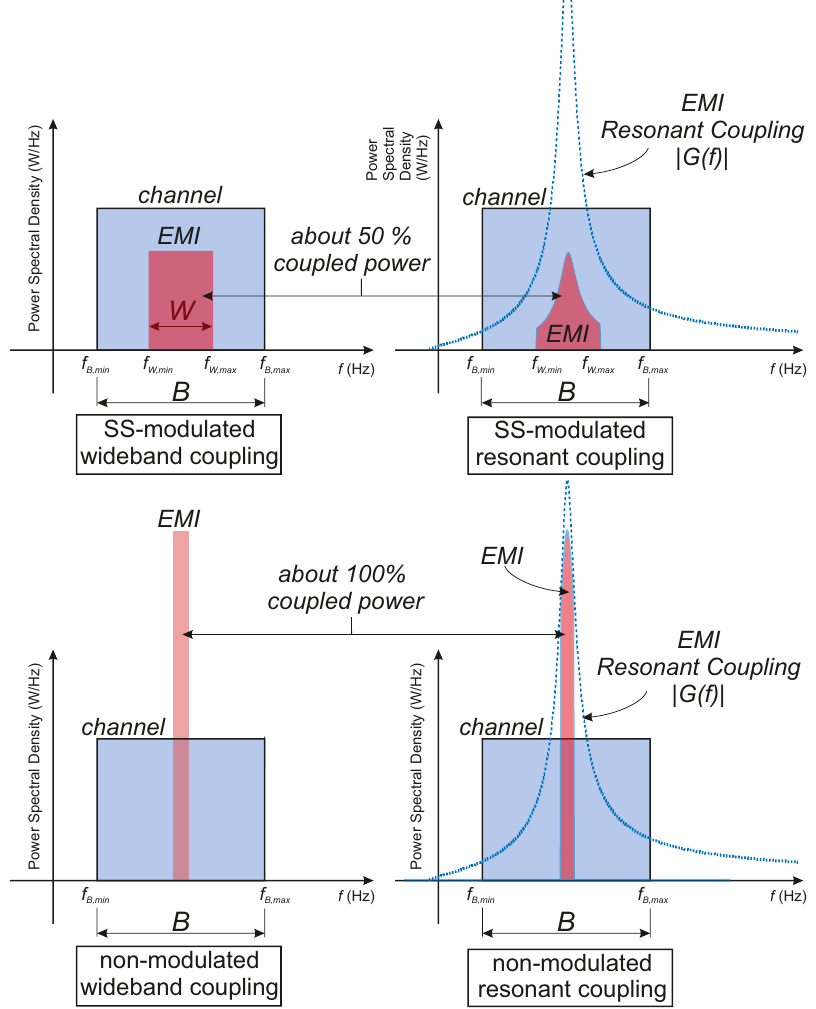
Figure 1. Effects of resonant coupling mechanisms on non-modulated and SS-modulated